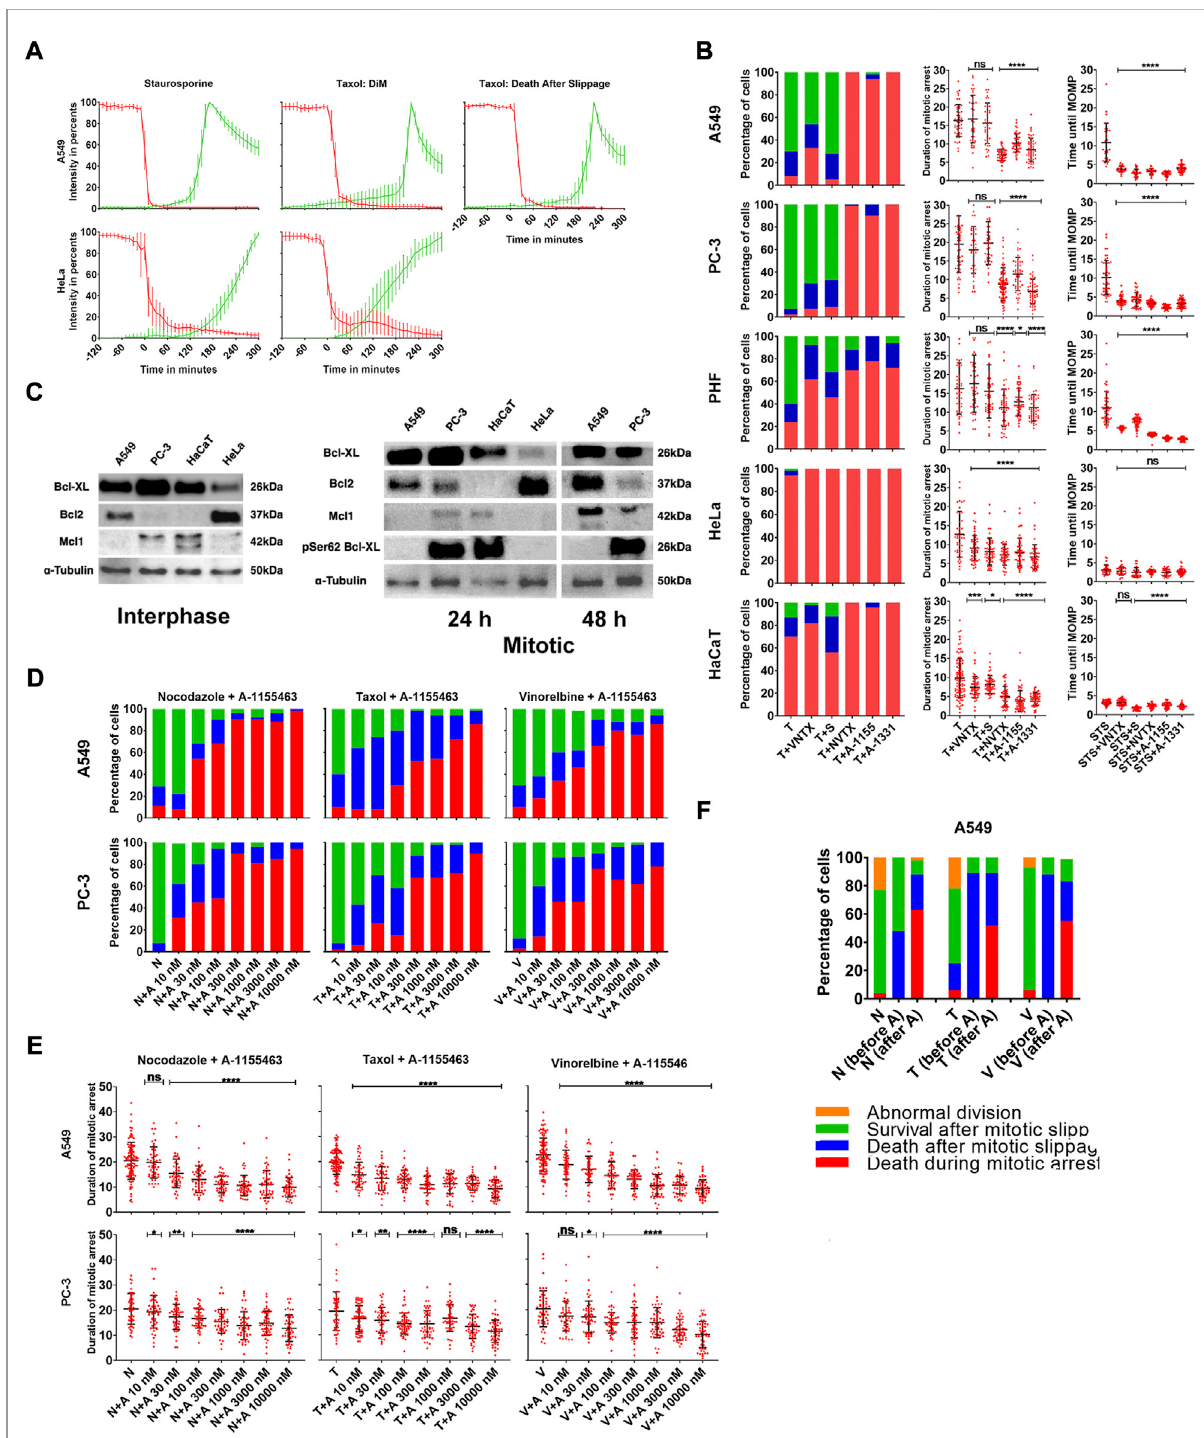
FIGURE 3 (A) Averaged and normalized intensity values from TMRE (red) and caspases 3/7 detecting reagent (green) for slippage prone A549- and DiM- sensitiveHeLacellsaftertreatmentwith1 µMstaurosporine(positivecontrolforapoptosis)or1 µMTaxol.VerticalbarsrepresentSD.N=10 – 15cells foreachcategory. (B) Distributionoffatesandaveragedurationsofmitoticarrest(inhours)ofPHF,slippageproneA549andPC-3,andDiM-sensitive HeLaandHaCaTcellsinresponsetothetreatmentwithTaxol(T)incombinationwithBcl-2inhibitorvenetoclax,Mcl-1inhibitorS63845(S),Bcl- 2, Blc-xL, and Bcl-w inhibitor navitoclax (NVTX) or speci fi c Bcl-xL inhibitors A-1155463 (A-1155) and A-1331852 (A-1331). As a positive control, fi ve cell lines were also treated with staurosporine (STS) in combination with each inhibitor of anti-apoptotic Bcl-2 proteins. The y-axis shows time